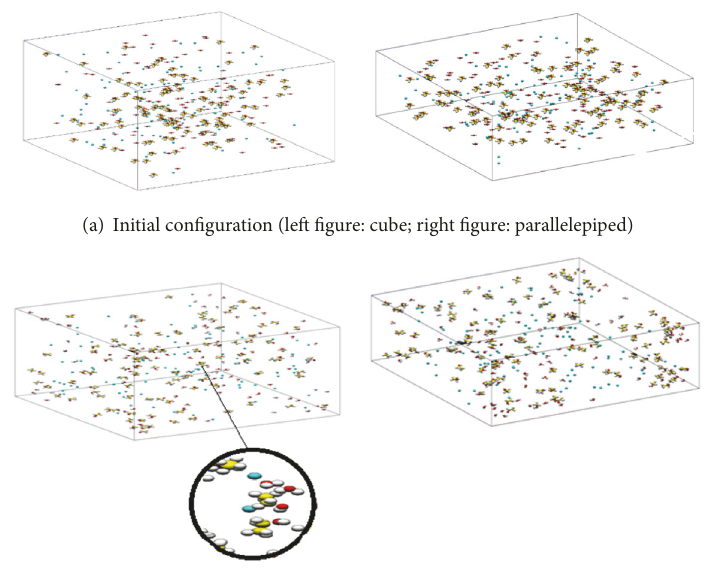
(b) Final configuration (left figure: cube; right figure: parallelepiped)